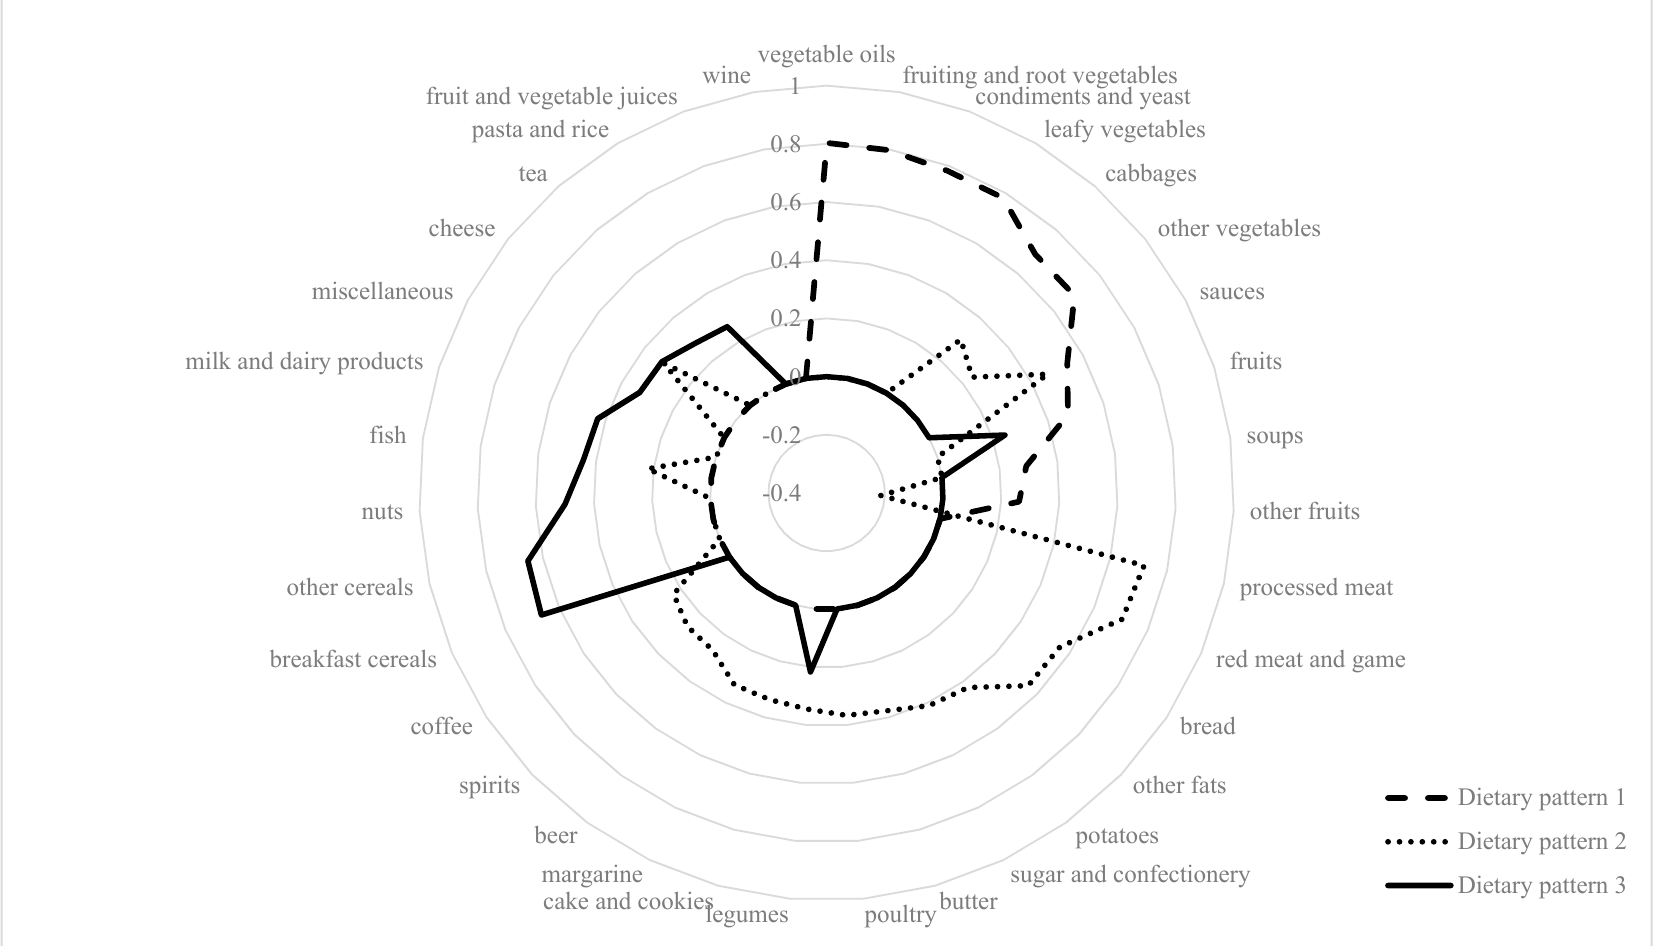
Figure 1. Spider web diagram from the Principal Component Analysis (factor loadings of food groups |> 0.20|).